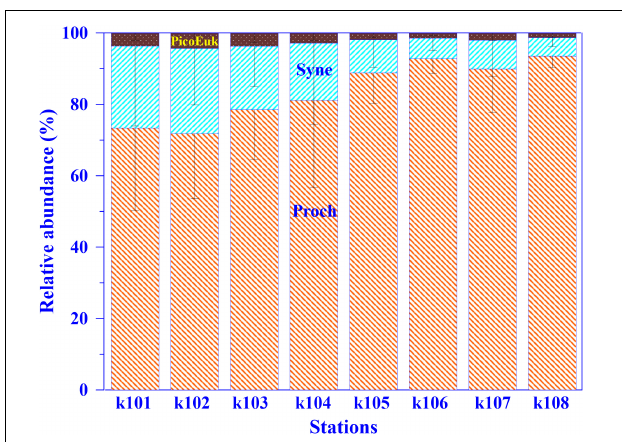
FIGURE 8 | The relative abundances of different autotrophic picoplankton, including Prochlorococcus (Proch), Synechococcus (Syne), and picoeukaryotes (PicoEuk), to total autotropic picoplankton (Proch + Syne + PicoEuk) for the upper 100 m depth over each sampling